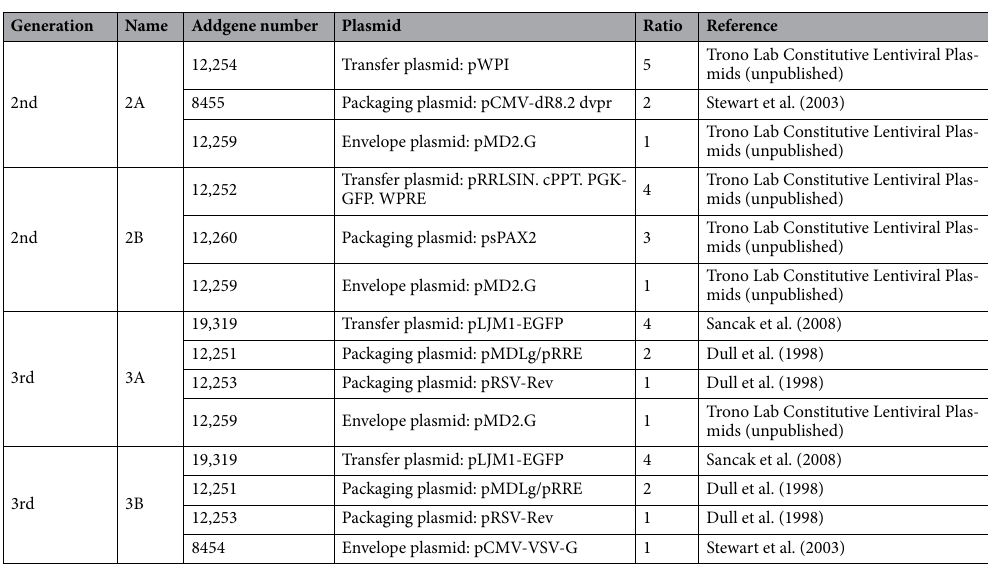
Table 1. Plasmids and ratios used to produce lentiviral vectors in this